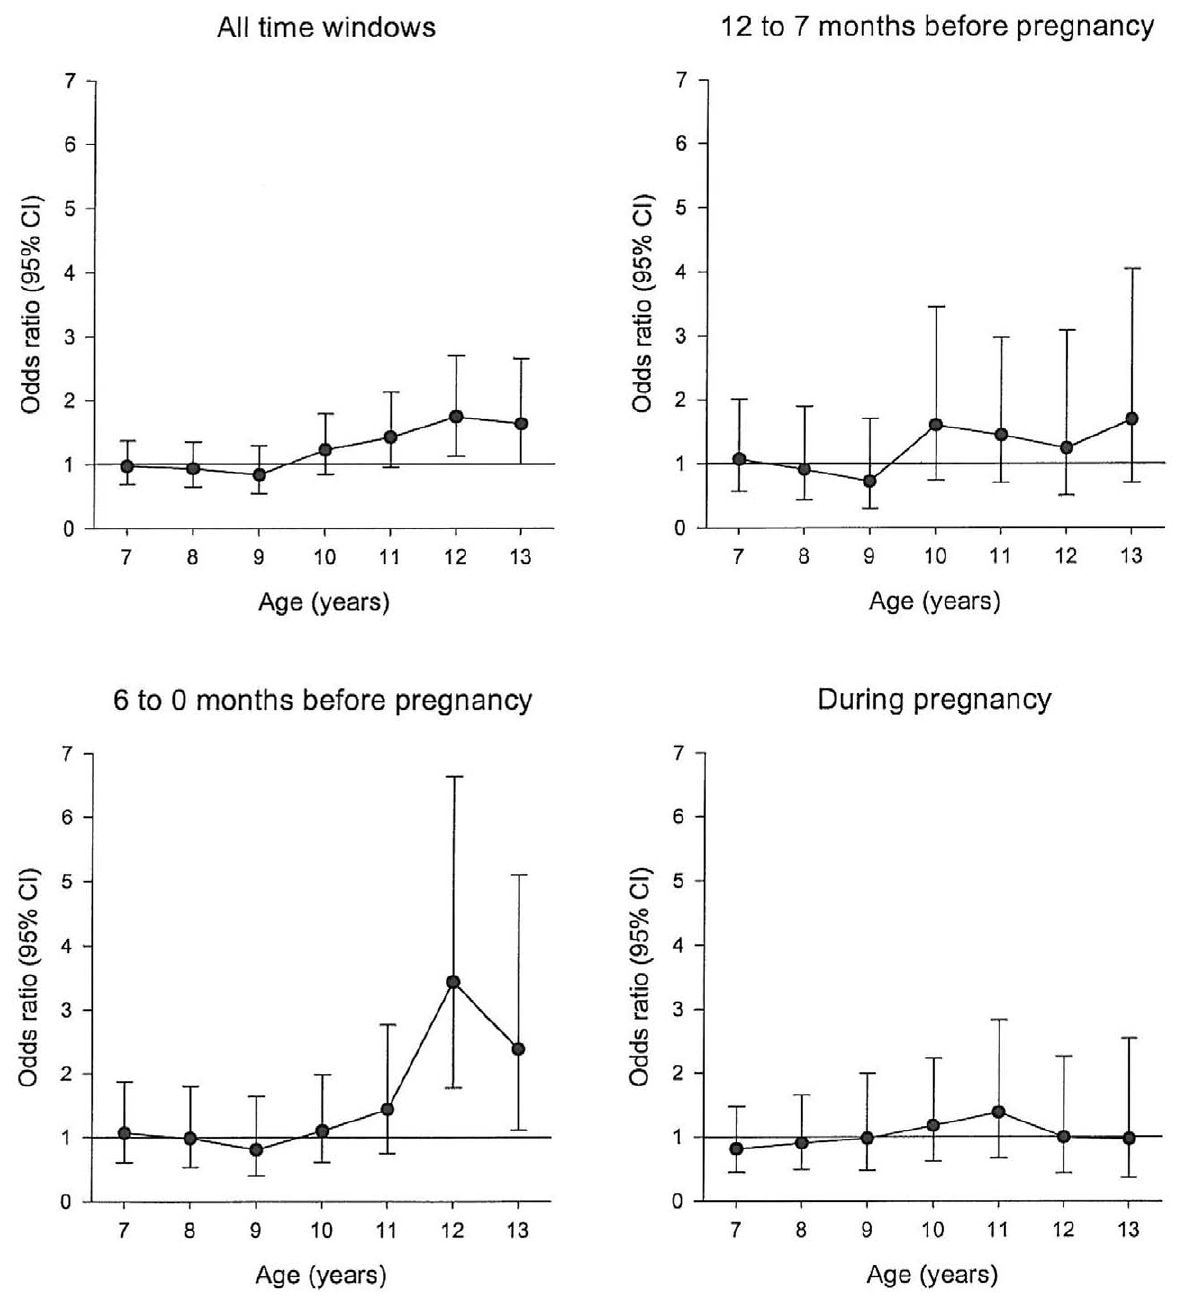
Figure 2. Odds ratio of overweight at ages 7 to 13 years between exposed and unexposed children by timing of exposure (logistic regression*). *Odds ratios adjusted for birth year, birth weight, gestational age, sex and maternal factors (age, education, income, and cohabitation status).